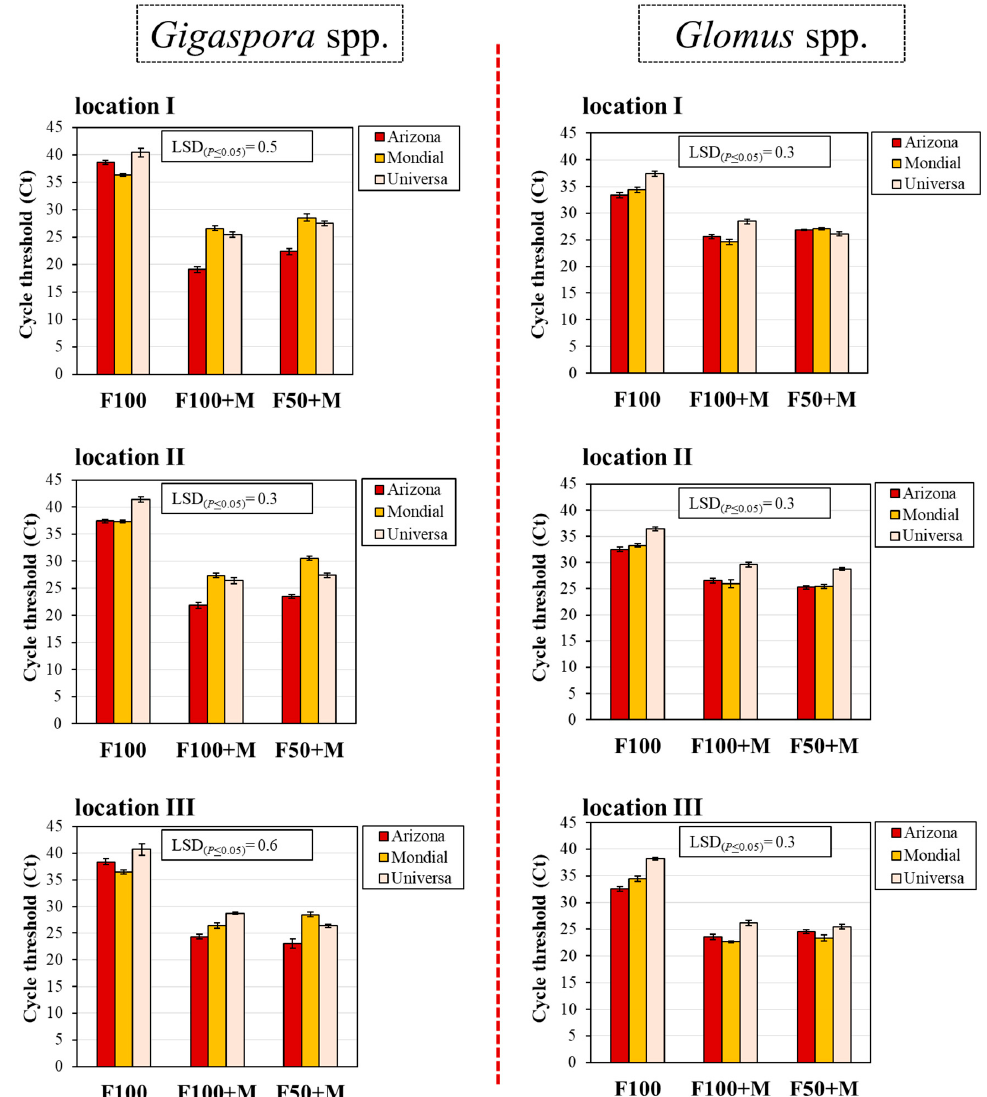
Figure 2. Amount of AMF Glomus spp. and Gigaspora spp., detected by qRT-PCR, in three different highly calcareous soils cultivated with organic early potato. The Least Significant Difference (LSD) interaction was calculated with the Fisher’s protected LSD test at α = 0.05. Each bar indicates means ± standard deviation ( n = 3). F100: optimal fertilization without mycorrhizal inoculation (control); F100 + M: optimal fertilization with mychorrhizal inoculation; F50 + M: sub-optimal fertilization